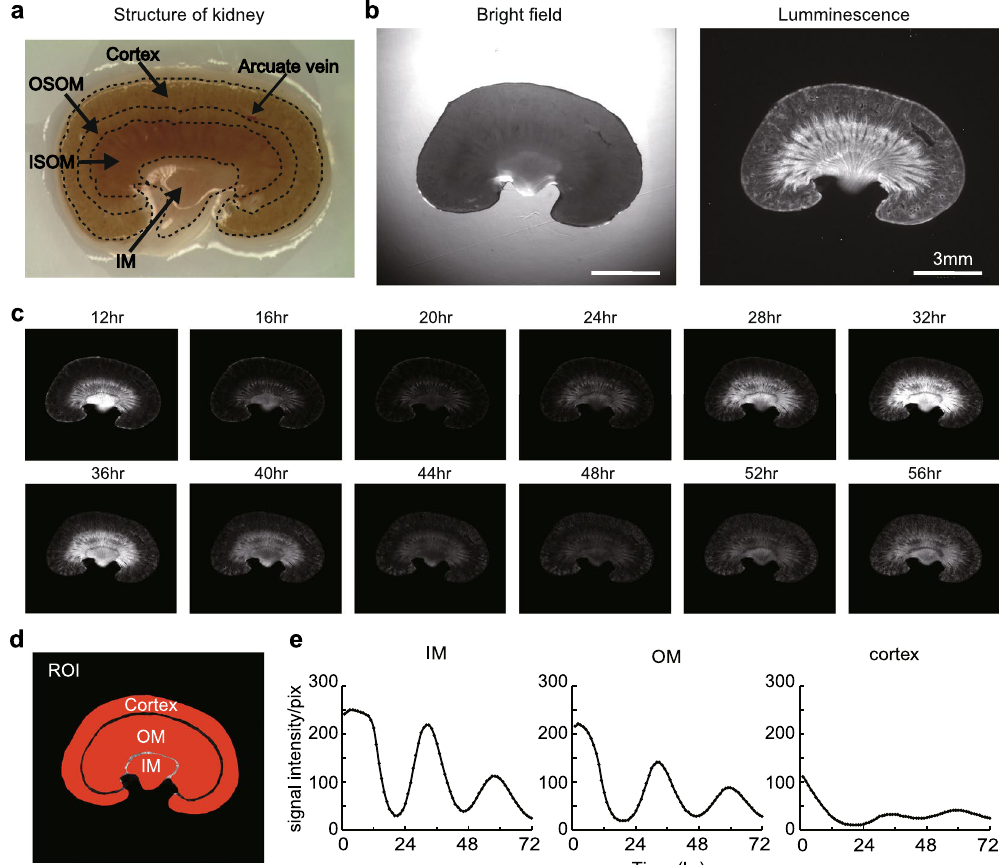
Figure 1. Localization of PER2::Luc activity in kidney. ( a ) Anatomical structure of mouse kidney. ( b ) PER2::Luc activity in slice cultured kidney. A bright field image (left) and a luminescence image (right) are displayed. White horizontal bar indicates 3 mm. ( c ) Time series observation of the bioluminescence in a slice cultured kidney. We set 0hr when we started observations. (d , e ) Quantitative analysis of regions of interest (ROIs) in the kidney slice. Set ROIs are shown in ( d ). Circadian rhythmic signal intensities were observed in the cortex, OM, and IM ( e ). OM, outer medulla; IM, inner medulla; OSOM, Outer stripe of outer medulla; ISOM, Inner stripe of outer